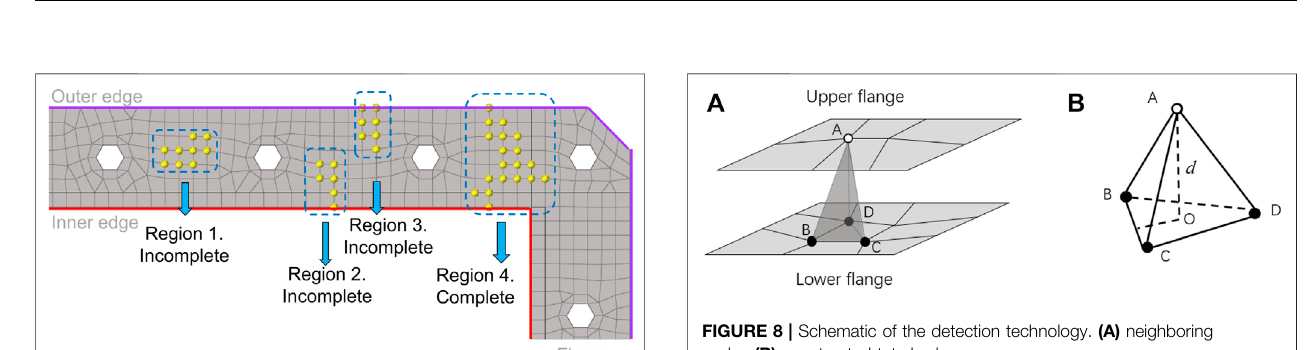
FIGURE 5 | Forces and moments in a bolt in 2D and 3D: F is the axial resultant force, M s is the resultant bending moment around the S axis, M t is the resultant bending moment around the T axis, Q is the resultant torsional moment, V s is the shear force along S , and V t is the shear force along T . (A) 2D (B) 3D.